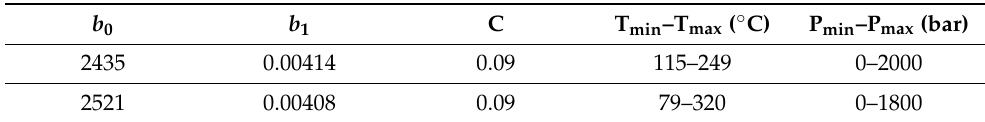
Table 3. Constants used in Equations (16) and (17) to calculate density of PS as a function of temperature and pressure.